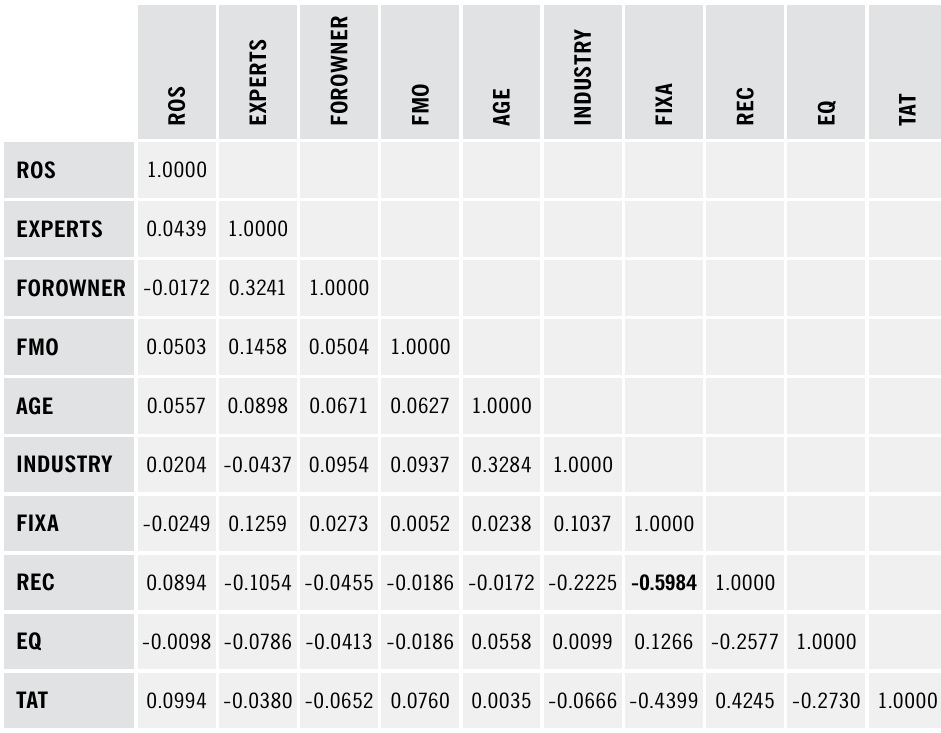
Table 6. Correlation matrix –